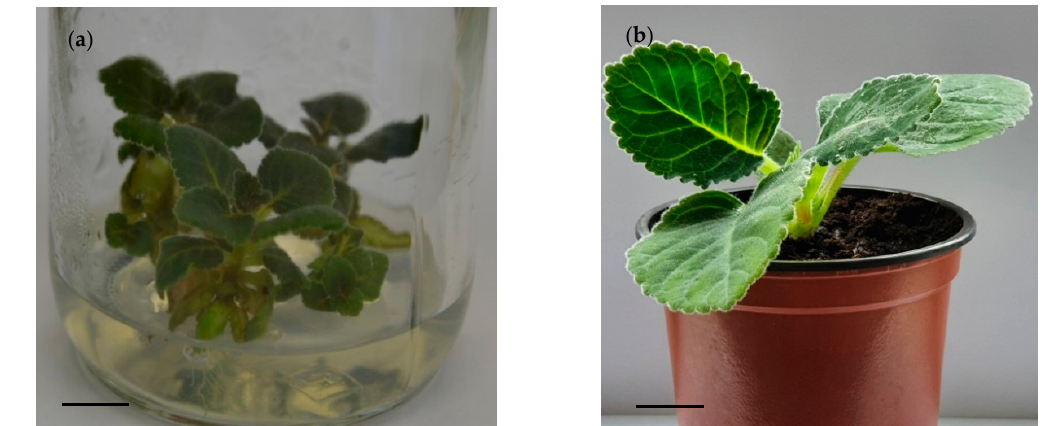
Figure 5. Rooted shoots on the rooting medium ( a ) and a hardened regenerated plant ( b ).